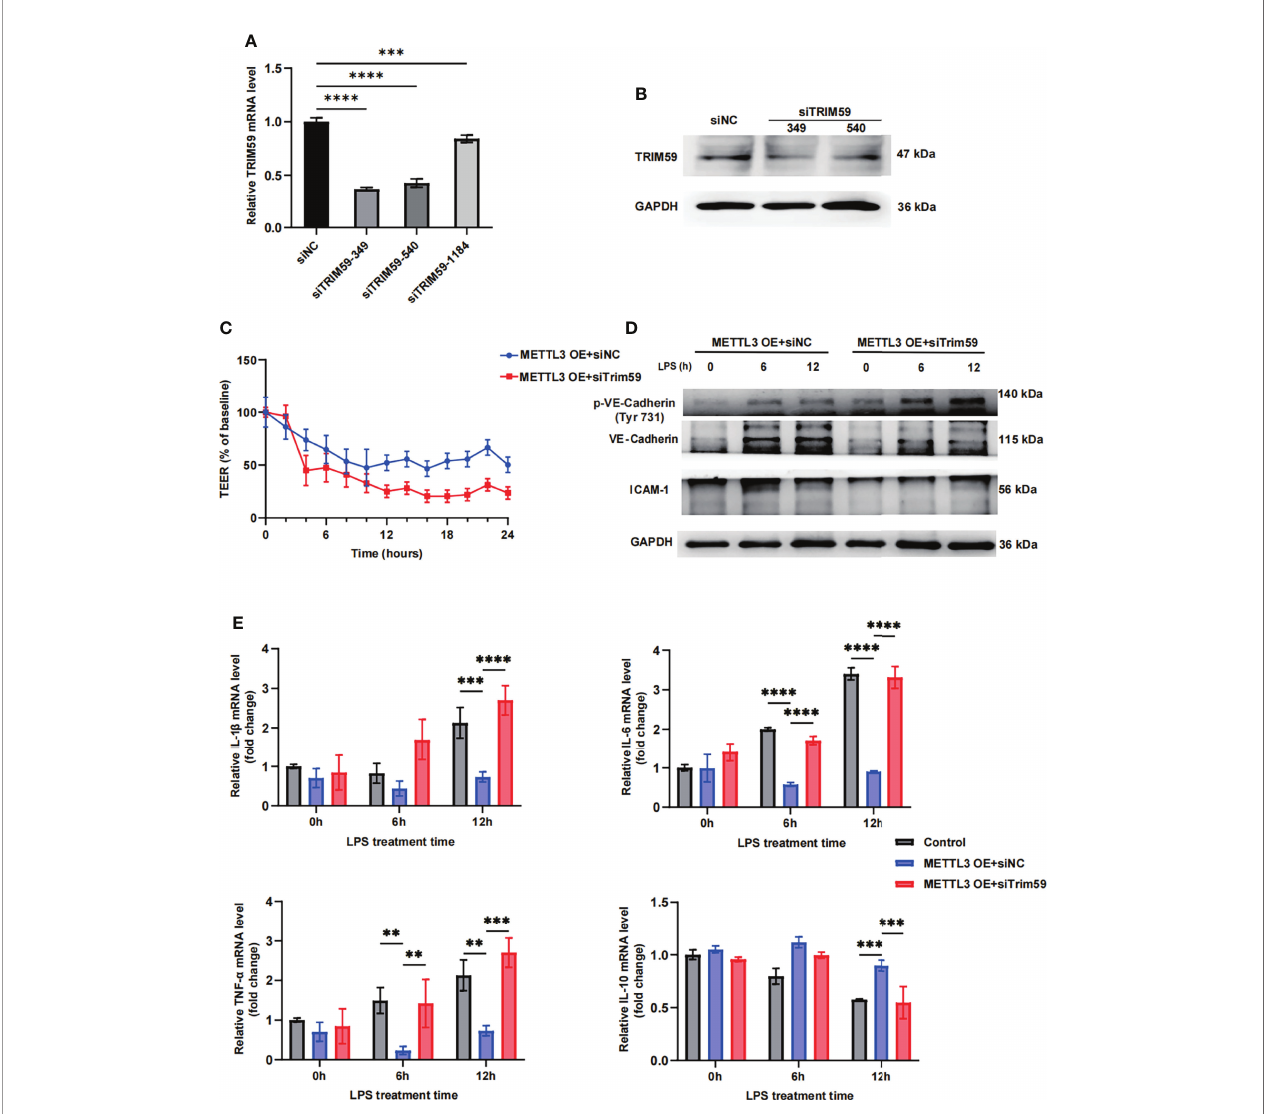
FIGURE 5 | METTL3regulates endothelialfunctionbytargetingTrim59. (A) RT-qPCR analysisshowingthelevelsofTrim59 expressionafter siRNAtransfection. (B) Immunoblot showingTrim59proteinexpressionafter siRNAtransfection. (C) TEER wasusedtomeasureendothelialpermeabilityinMETTL3-overexpressingHULEC-5acellswithor without Trim59 siRNA. (D) ImmunoblotshowingtheproteinexpressionofVE-CadherinandICAM-1inMETTL3-overexpressing HULEC-5acells withorwithoutTrim59 siRNA. (E) RT- qPCR analysisshowingin fl ammatorycytokinemRNAexpressioninMETTL3-overexpressingHULEC-5acellswithor withoutTrim59siRNA. Alldataare expressedasthemean± SDofthreeindependentexperiment.** p <0.01; *** p < 0.001; **** p <